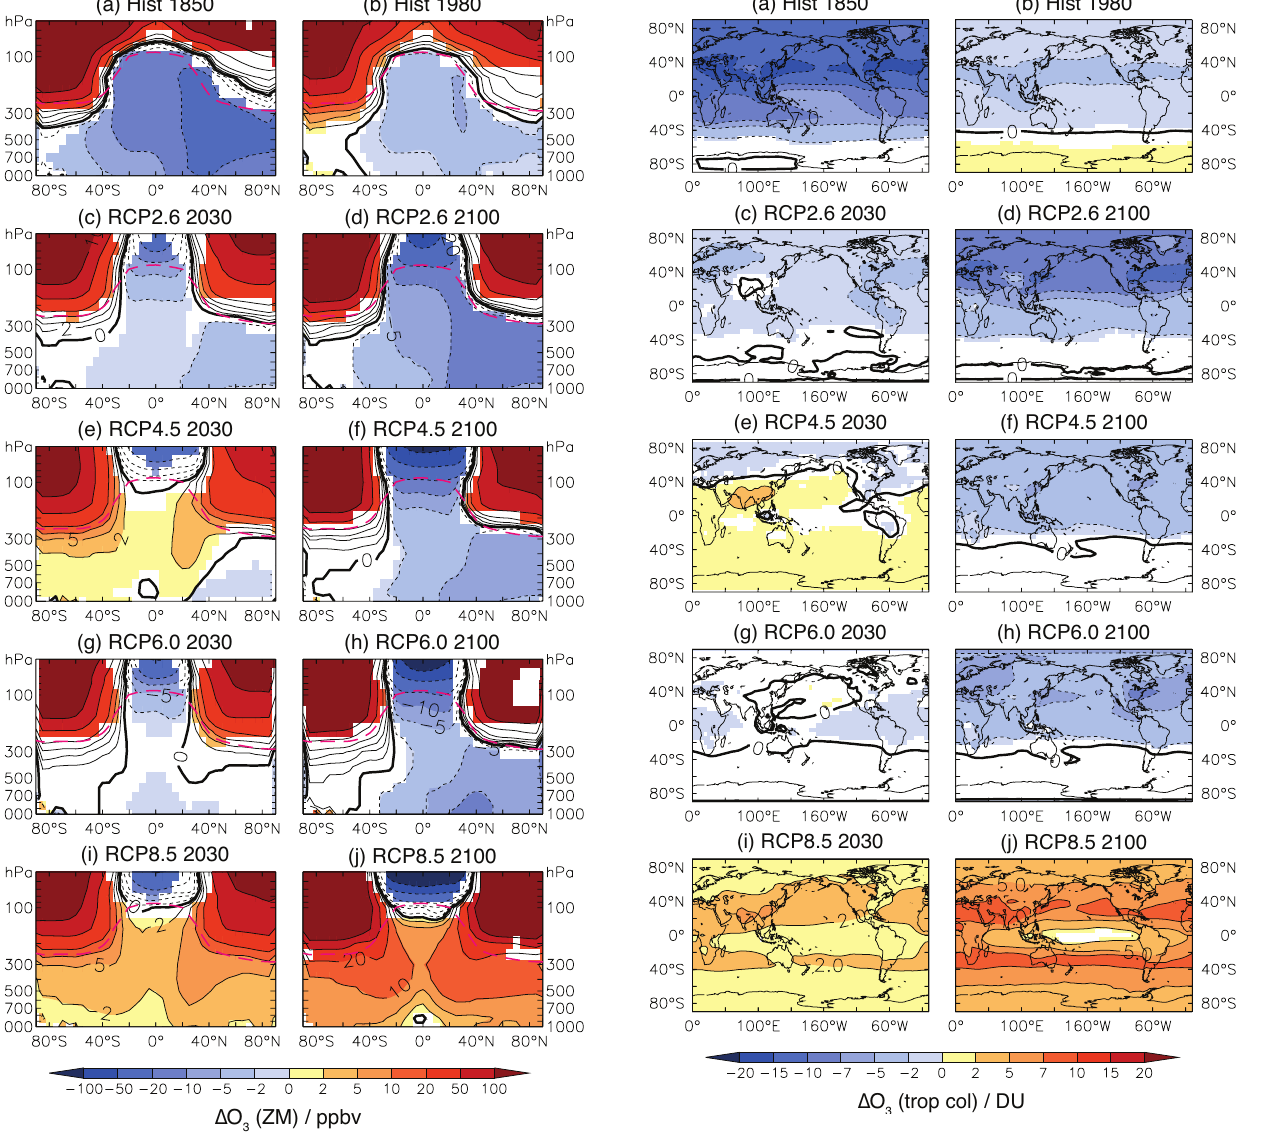
Fig. 9. Absolute change in annual zonal mean ozone for the AC- CMIP ensemble mean compared to the Hist 2000 simulation (ppbv). Top row shows the difference for the Hist 1850 and 1980 time slices. The next four rows show the difference for the 2030 and 2100 time slices of the RCP simulations. Non-white regions indicate where the change is significant at the 5% level, based on the spread of the differences between the models. The red dashed line indicates the position of the annual zonal mean 150ppbv ozone contour from the Hist 1850 simulation.